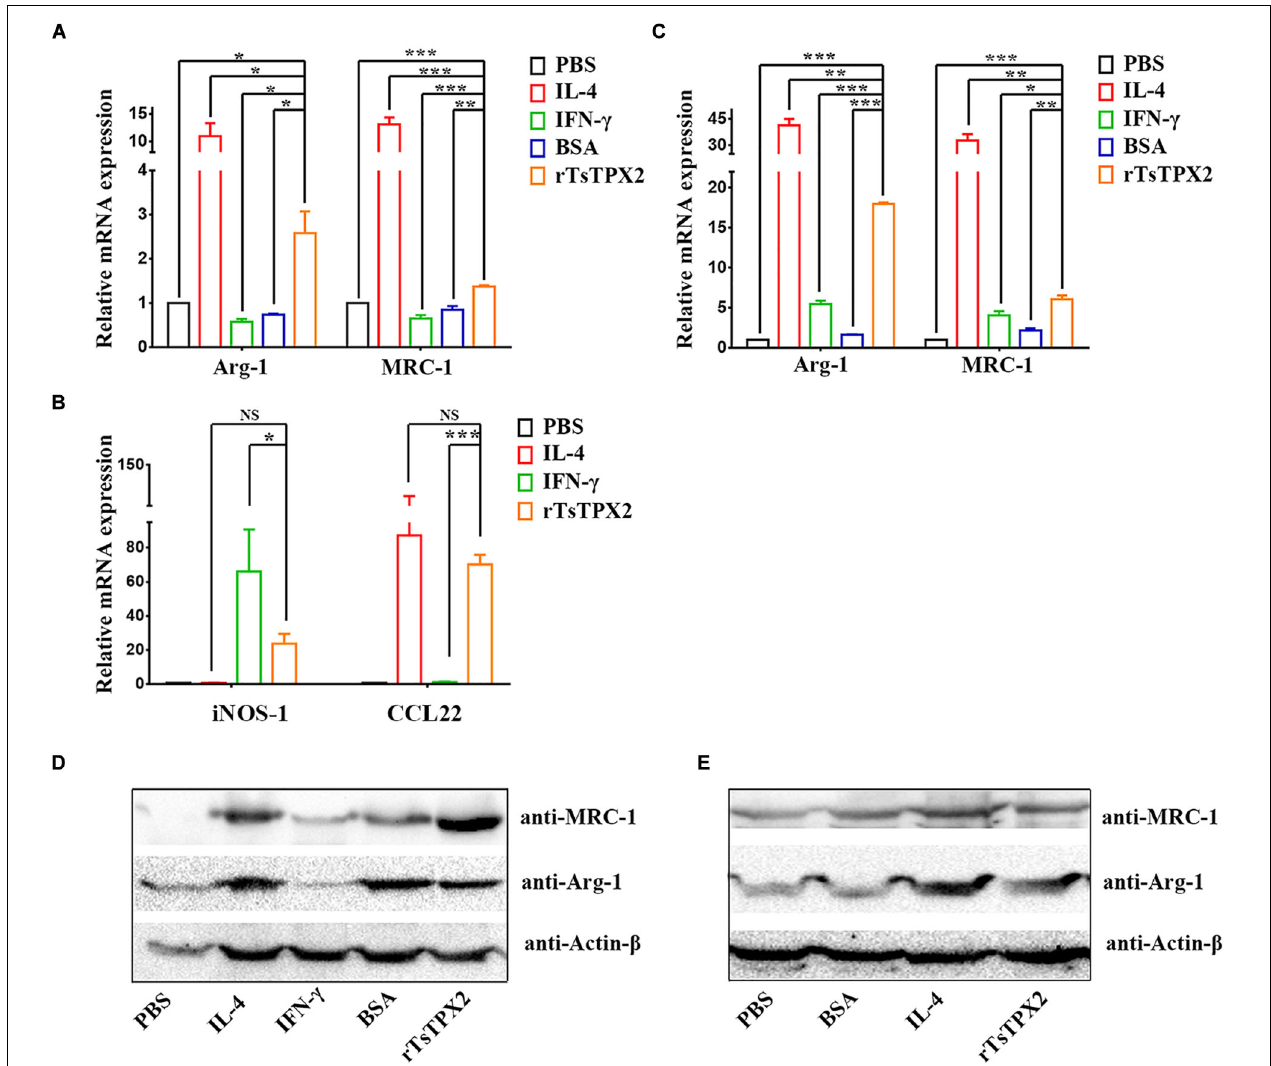
FIGURE 3 | The phenotype of macrophages induced in vitro. (A–E) The expressions of M1 and M2 markers were analyzed by both qRT-PCR (A–C) and Western Blotting (D,E) . (A,B) Analysis of the expression of Arg-1 MRC-1, iNOS-1 and CCL22 genes in RAW264.7 co-cultured with various stimuli by qPCR. (C) Analysis of the expression of Arg-1 and MRC-1 genes in peritoneal macrophages isolated from healthy BALB/c mice after co-cultured with various stimuli by qPCR. (D,E) Analysis of the expression of Arg-1 and MRC-1 genes in RAW264.7 and peritoneal macrophages after co-cultured with various stimuli by Western Blotting. Experimental groups include macrophages stimulated with PBS as blank control, IL-4 as M2 positive control, INF- γ as M1 positive control, BSA as mock control or rTsTPX2. Statistical analysis was performed with Student’s t -test, and data are presented as mean ± SDs (representative of three experiments). *** P < 0.001, **0.001 < P < 0.01, *0.01 < P < 0.05. n > = 5 mice per